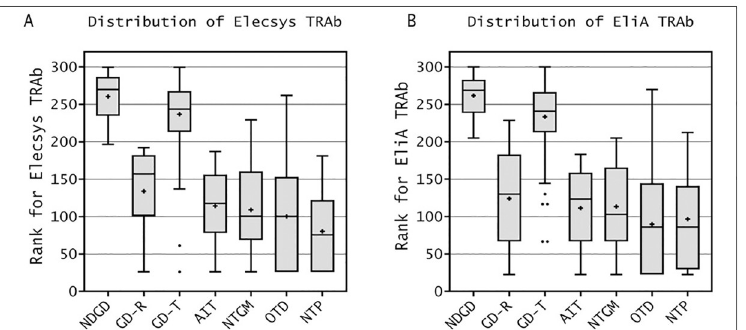
Fig 4. Box-plot of Kruskal-Wallis analysis. A. Elecsys 1 TRAb levels in the different groups enrolled in the study. B. EliA ™ TRAb levels in the different groups enrolled in the study. TRAb levels are displayed as data ranks obtained by transforming to continue data ranks using Roche’s test. For each box plot, the central line represents the median; the boxes limits represent the upper and lower quartile; black points are outliers (a value more than 1.5 times the interquartile range above/below the interquartile values); and the black lines are the whiskers, which extend from the interquartile ranges to the maximum values that are not classed as outliers.